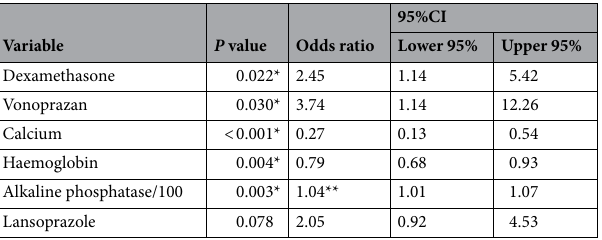
Table 2. Results of multivariate ordered logistic regression analysis for variables extracted by forward selection (n = 327). CI, confidence interval. * P < 0.05. **Odds ratio per ALP 100